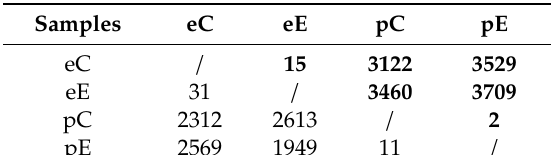
Table 4. Di ff erentially expressed genes (DEG) of Q. pubescens leaves in response to the sampling season and the rain exclusion treatment. The thresholds of statistical tests were fixed at p adj < 10 − 3 and log2FC ≥ 2. 5724, and 4153 DEG were detected by DESeq2 (bold) and edgeR, respectively; e and p denote sampling in summer and spring, respectively; C and E denote control and rain exclusion treatments, respectively.